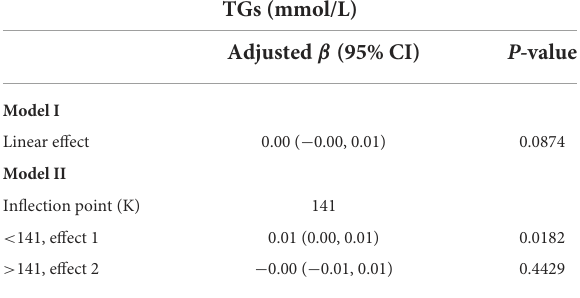
TABLE 4 Threshold effect analysis of the relationship between Hb and TG levels.